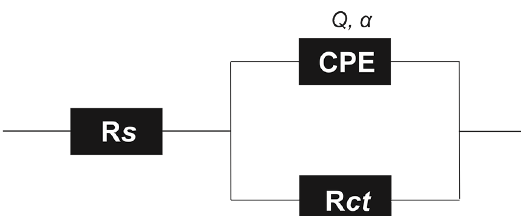
Figure 2. Equivalent circuit used to fit the EIS data of C-steel in 1.0 mol∙L -1 HCl without and with different concentrations of Aniba canelilla